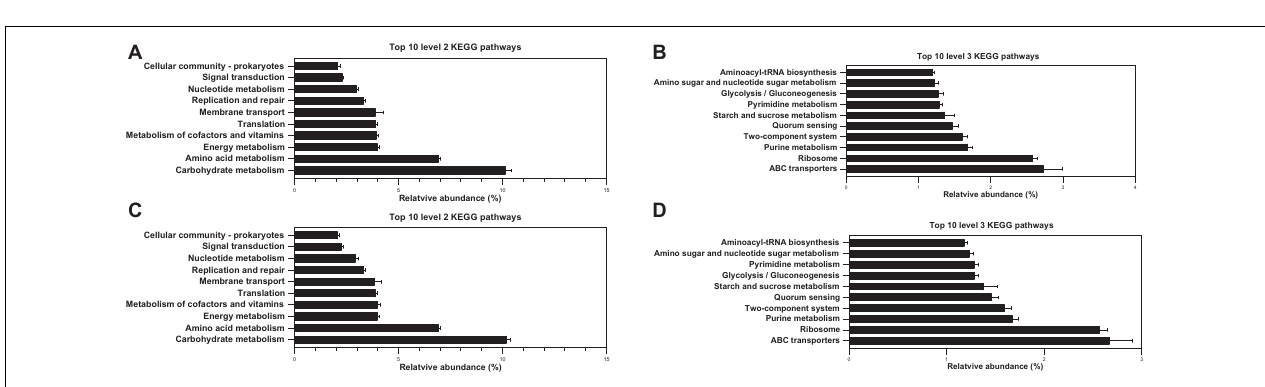
FIGURE 7 | Effects of different diets on intestinal and fecal different bacteria in weaned piglets. (A,B) Top 30 different bacteria at the genus level of the colon in weaned piglets. (C–F) Distribution of top 30 different fecal bacteria at the genus level in weaned piglets. C, Basal diet (Calcium carbonate + 1/1,000 g/kg of acidifier); L, 5/1,000 Calcium citrate diet + 1/1,000 g/kg of acidifier; D, 5/1,000 Calcium citrate diet + 1/1,000 g/kg of acidifier + 1/1,000 g/kg organic trace minerals; M, 5/1,000 Calcium citrate diet + 0.5/1,000 g/kg of acidifier + 1/1,000 g/kg organic trace minerals; P, 5/1,000 Multiple calcium diet + 1/1,000 g/kg of acidifier + 1/1,000 g/kg organic trace minerals.